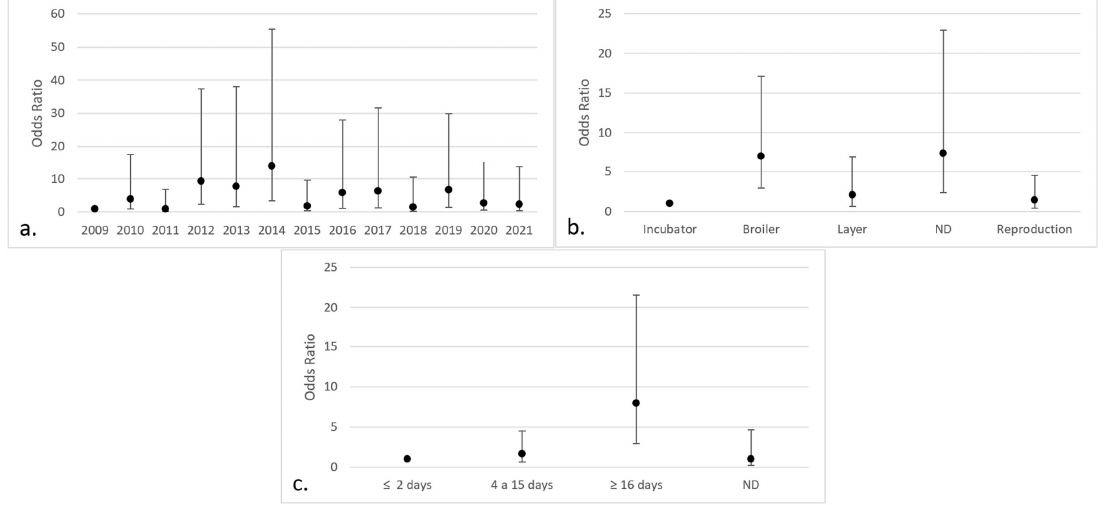
Figure 6. Categories with the highest risk of positive isolates for Aspergillus section Flavi (95% CI) in chicken lungs ( Gallus gallus ) from 2008 to 2021 in the Mycology Laboratory, School of Veterinary Medicine, Universidad Nacional, Heredia, Costa Rica. ( a ) Year of remission; ( b ) productive purpose of the bird; ( c ) bird age. 2009 includes 2008; ND = non-determinate production purpose or age of the bird.